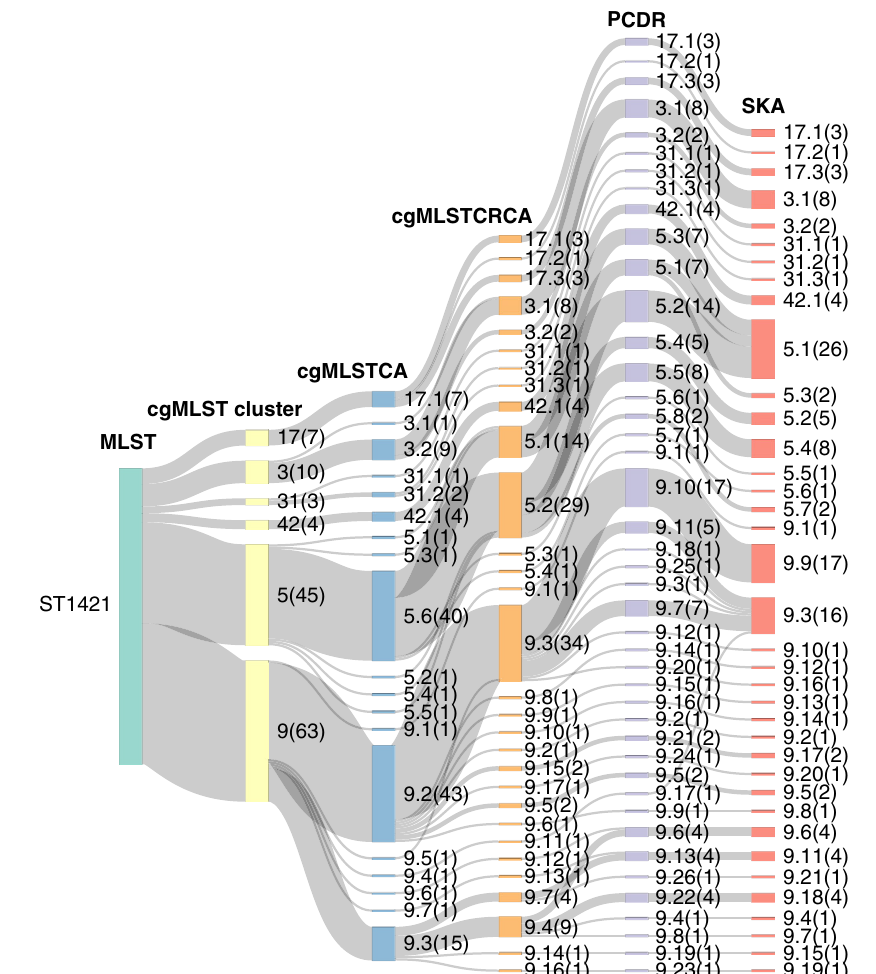
Fig. 2 Relationship between methods for determining genomic clusters for E. faecium isolates from the major multilocus sequence type (ST1421 n = 134). Core genome multilocus sequence type (cgMLST) clusters are based on single-linkage clustering using a pairwise allelic difference threshold of ≤ 25 alleles. cgMLST core alignment (cgMLSTCA), cgMLST with cluster reference core alignments (cgMLSTCRCA), pairwise comparison using de novo references (PCDR) and split kmer analysis (SKA) clusters are based on a pairwise single nucleotide polymorphism (SNP) distance threshold determined based on intrapatient SNP diversity (cgMLSTCA: ≤ 44 SNPs, cgMLSTCRCA: ≤ 6 SNPs, PCDR: ≤ 10 SNPs, SKA: ≤ 7 SNPs) and are generated using single linkage clustering. The size of the nodes represents the number of isolates in each of the clusters and is relative for each multilocus sequence type (MLST) and the number of isolates in each cluster is displayed in brackets. PCDR was used as the gold standard method and so the genomic clustering pattern of the other methods should be as close as possible to PCDR.